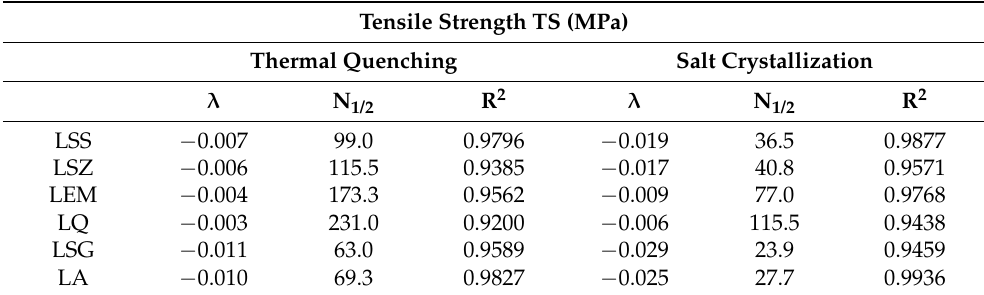
Table 6. Decay constant ( λ ), half-life (N 1/2 ), and coefficient of determination (R 2 ) of tensile strength parameter due to cyclic thermal shock and salt crystallization.